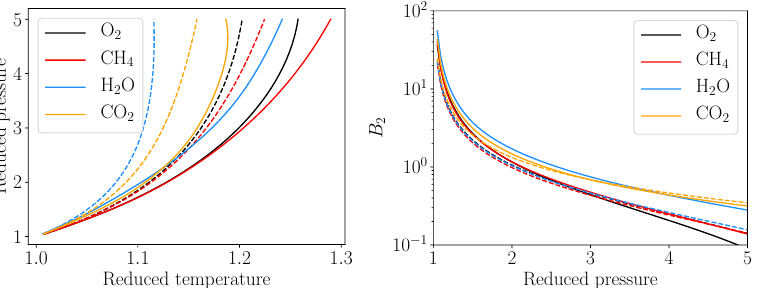
Figure 6. Pseudo boiling properties compared between PR EOS (dashed) and reference data (solid). Left: The pseudo boiling line as the locus of c p peaks shows pronounced differences between both data sets. (Right) the pseudo boiling strength B 2 [29] is underpredicted for reduced pressures up to 3; beyond is well matched for carbon dioxide, but not for the other species.